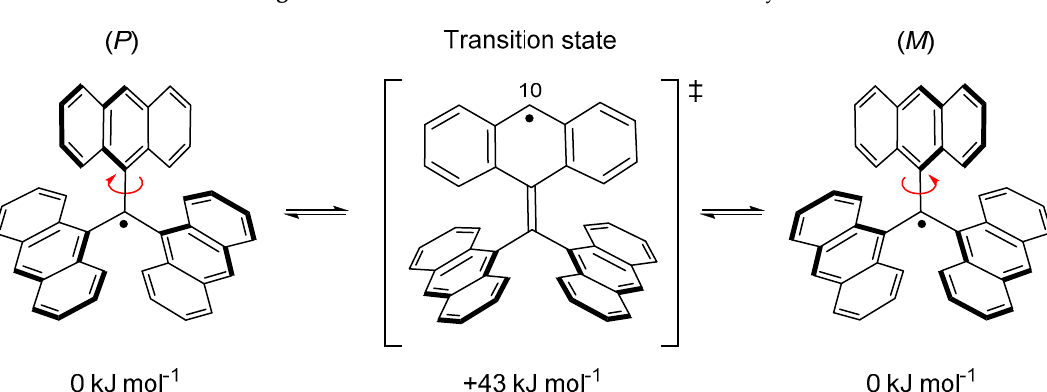
Figure 15. Dimerization reaction of 16 . Mes = mesityl.